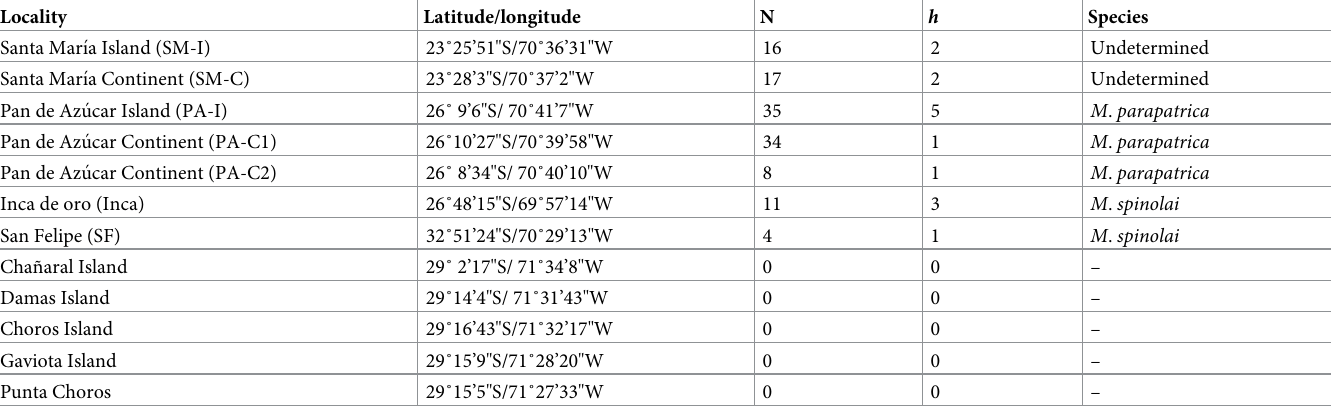
Table 1. Geographical coordinates of collection localities of individuals of Mepraia from insular and continent zones.